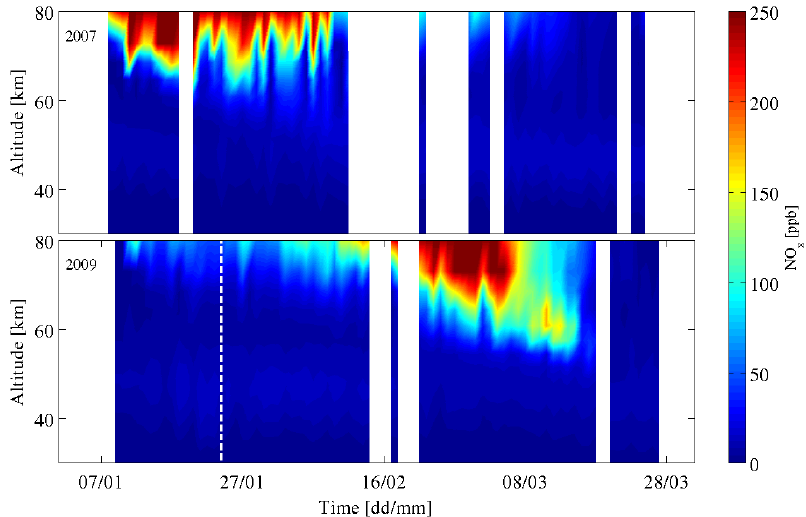
Fig. 5. NO x time series (ppb) as daily means from FinROSE-CTM. White dashed line indicates the time point, when the criteria for the major SSW were fulfilled in 2009. The upper panel is for 2007 and the lower for 2009. White regions indicate missing ACE-FTS data or not enough ACE-FTS